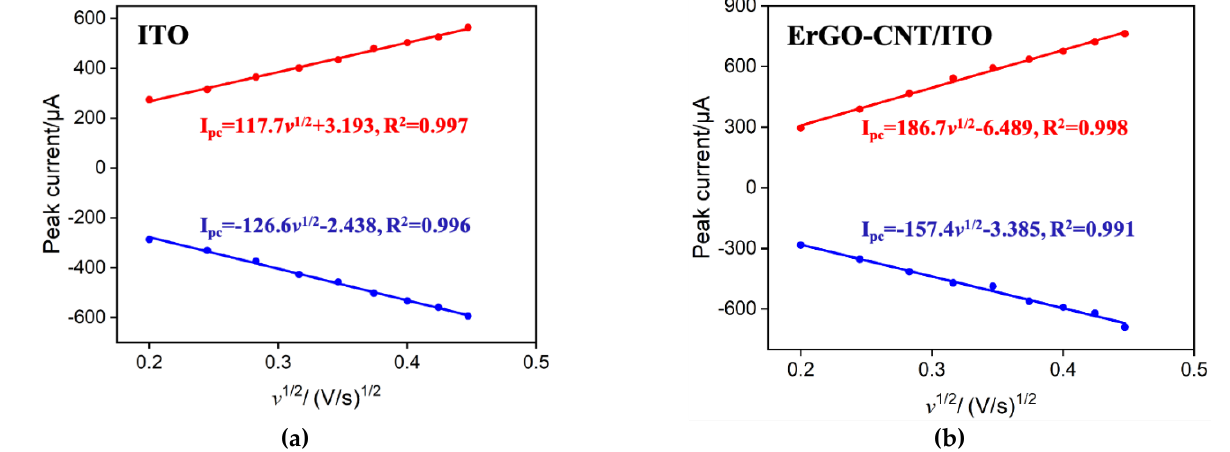
Figure 5. Relationship between peak current vs. square root of scan rate derived from the CV curves of bare ITO ( a ) and ErGO-CNT/ITO ( b ) electrodes obtained in 0.05 M KHP containing 0.5 mM K 3 [Fe(CN) 6 ].